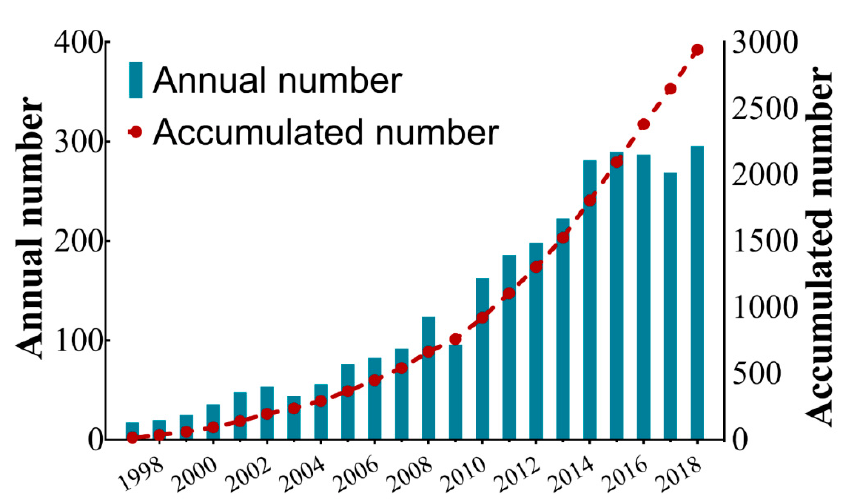
Figure 2. Accumulated number and annual number of genetic factors in autism spectrum disorder (ASD) publications from 1997 to 2018.